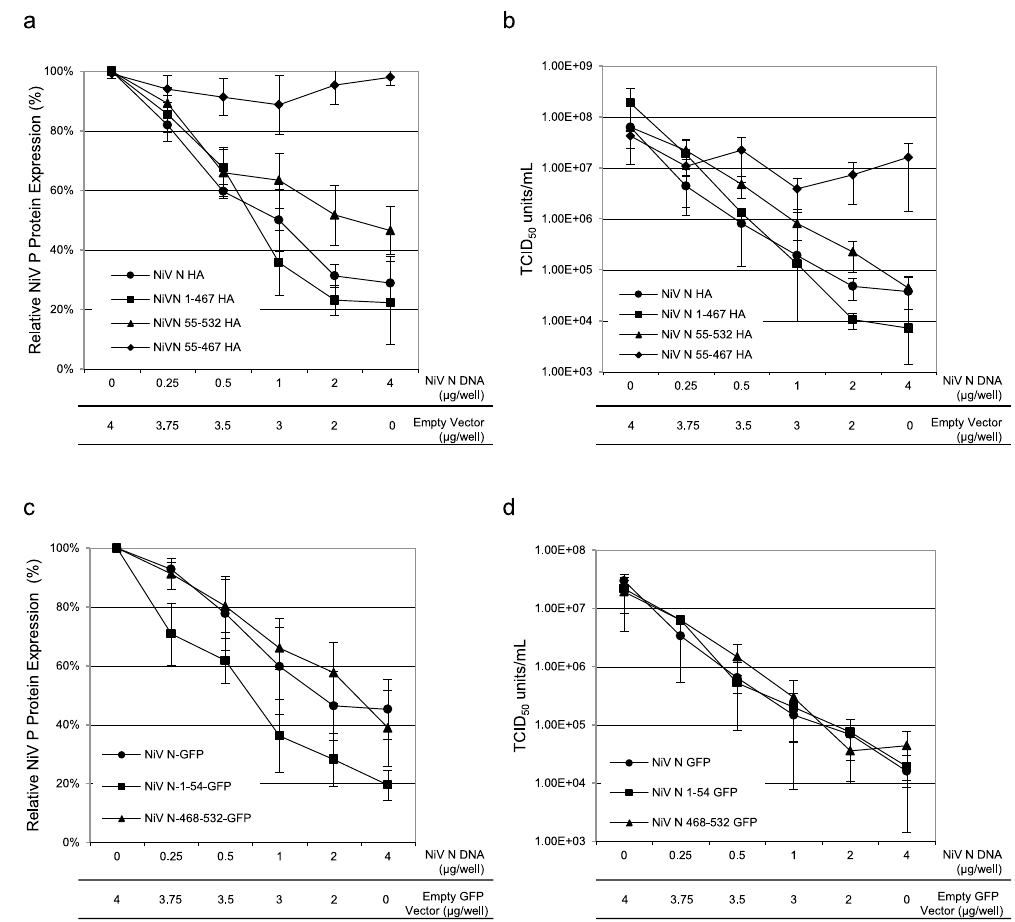
Figure 8. Analysis of NiV replication as expression levels of truncated NiV N-HA protein increase. All experiments were carried out in triplicate and standard deviations of the mean were calculated. Cells transiently expressing increased amounts of various truncated NiV N proteins were infected with NiV at an MOI of 1 for 24 hours. Lysates were harvested from cells expressing ( a ) NiV N truncations fused to an HA tag or ( c ) NiV N truncations fused to GFP and analyzed by western blots using a monoclonal antibody against NiV P. Western blots were quantified by densitometry and normalized against the expression of actin. Expression levels of viral NiV P in the absence of recombinant NiV N was set to 100% expression. Supernatants were harvested from cells expressing ( b ) NiV N truncations fused to an HA tag or ( d ) NiV N truncations fused to GFP, viral loads were determined by endpoint titration and TCID 50 /ml was calculated. All experiments were done in triplicate and standard deviations of the mean were